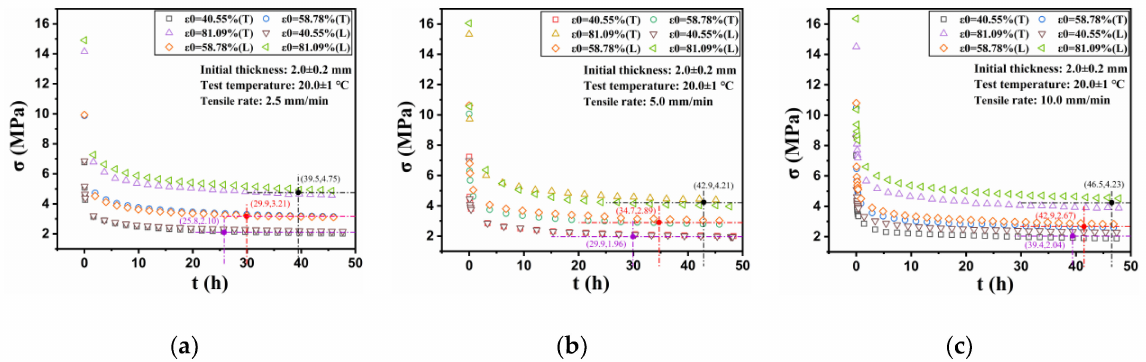
Figure 4. Stress relaxation curves at different tensile rates and initial strains: ( a ) v = 2.5 mm/min; ( b ) v = 5.0 mm/min; ( c ) v = 10.0 mm/min.